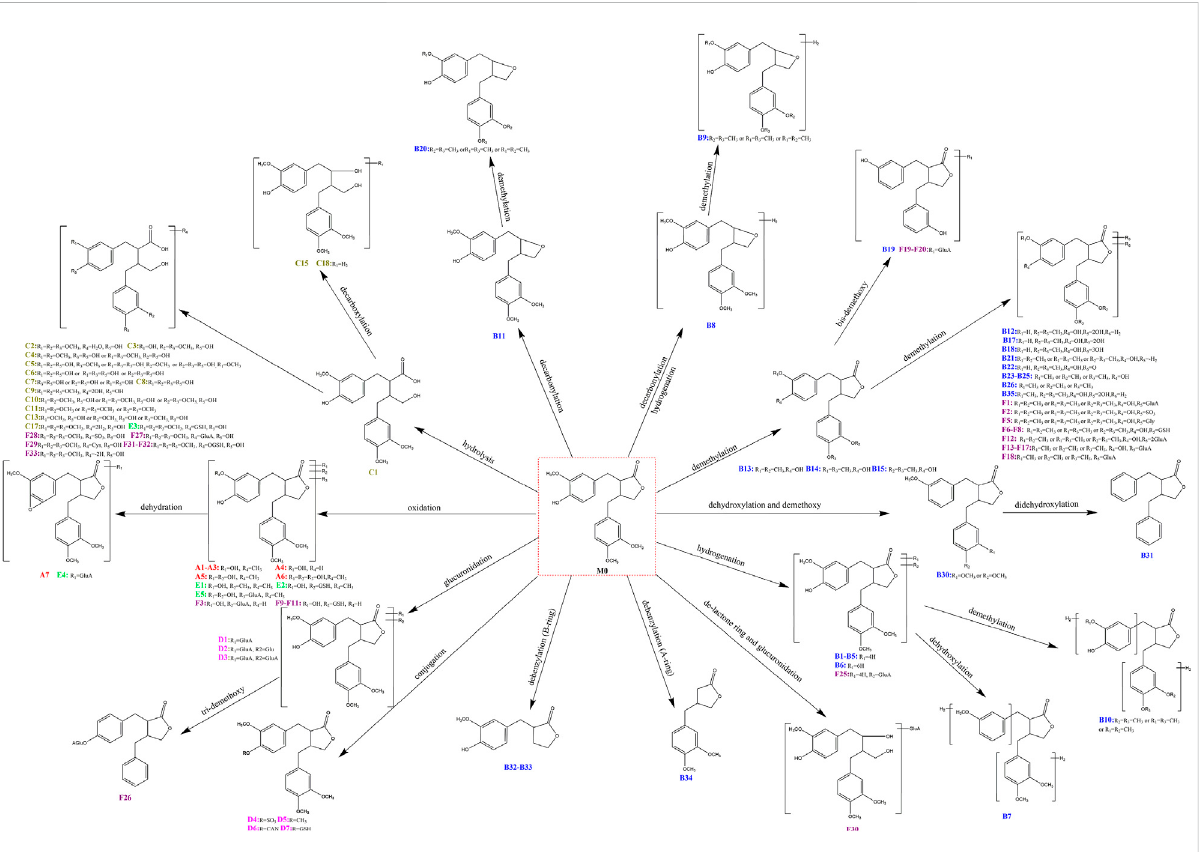
FIGURE 4 The proposed metabolic pathways of 105 identi fi ed arctigenin